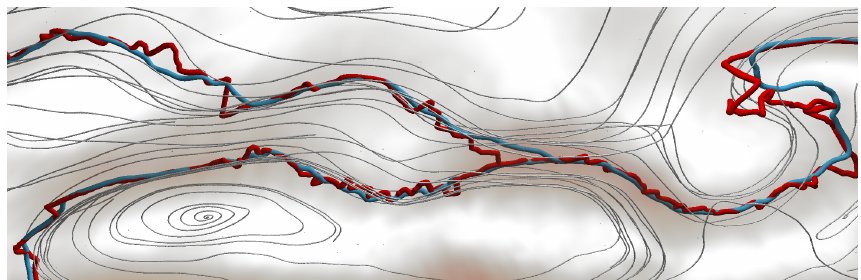
Figure 1. Extremal lines (red lines) of the wind magnitude are sensitive to the data discretization and thus do not follow the streamlines (gray lines) of the wind field. In contrast, our jet core lines (blue lines) balance between extremal lines and flow alignment. All lines are traced in 3-D and may therefore intersect on the viewport. Locations with wind speed between 10 and 40ms − 1 are highlighted with gray-red color in the background, showing that jet core lines reside in high velocity regions. The data here are for 1 September 2016 at 00:00UTC.